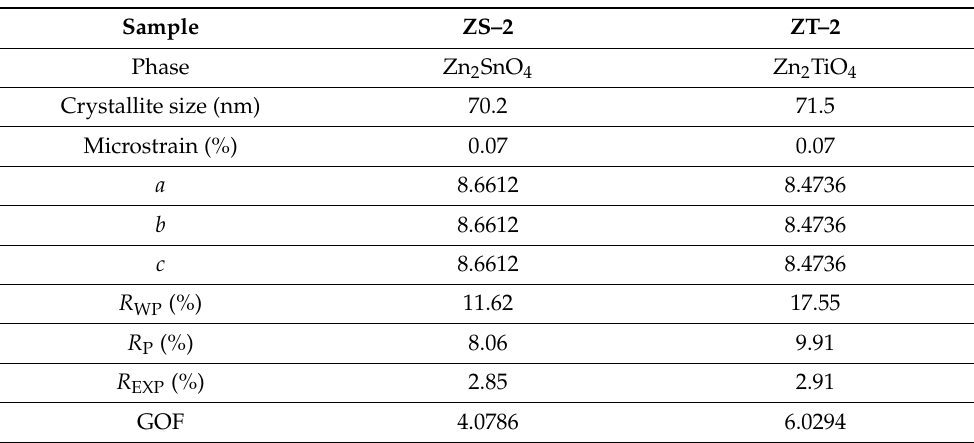
Table 3. Structure parameters of ZS–2 and ZT–2 by Rietveld